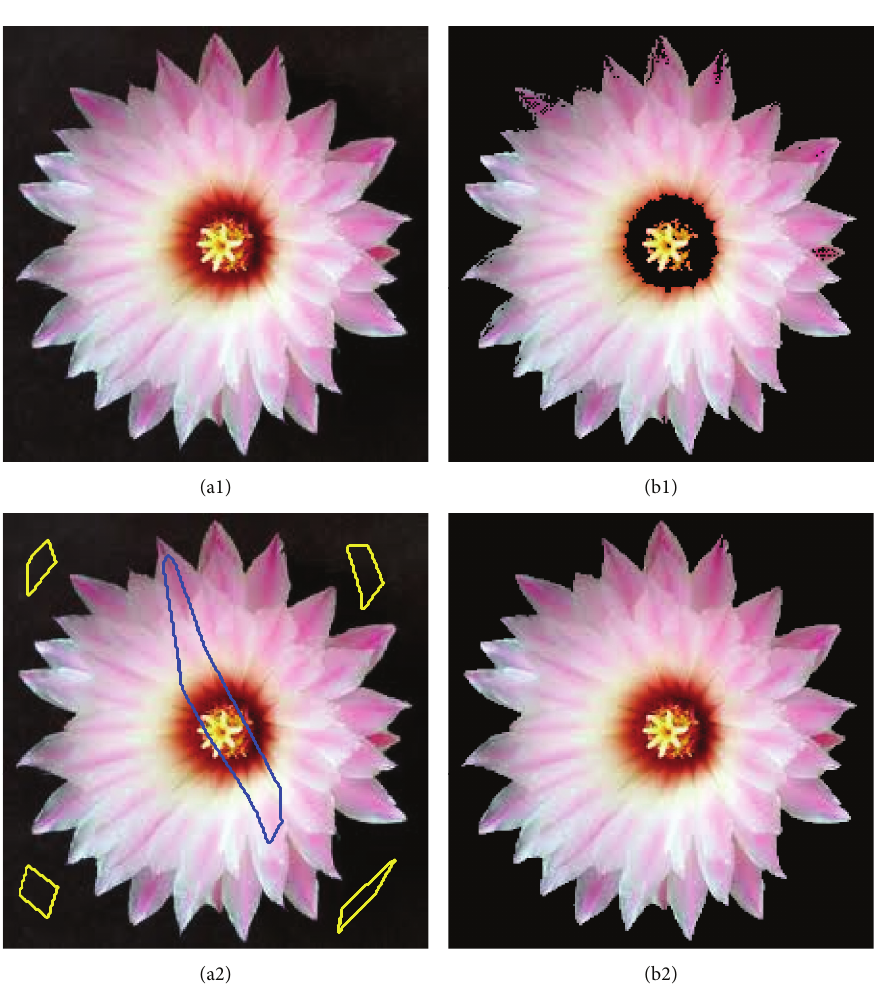
Figure 4: Comparison between segmentation models using supervised method and unsupervised method. (a1) Original image of a flower. (a2) Original image of a flower with assigned class masks. (b1) Unsupervised segmentation for the flower. (b2) Semisupervised segmentation for the flower.